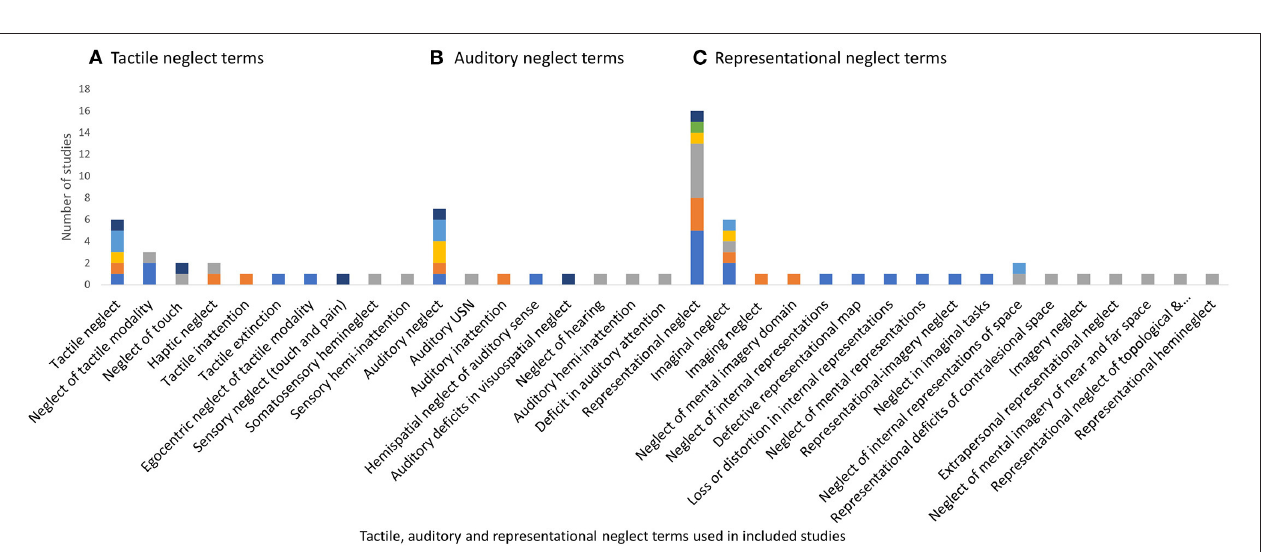
FIGURE 5 | Tactile, auditory, and representational neglect terms used within included studies. (A) Tactile, (B) auditory, and (C)